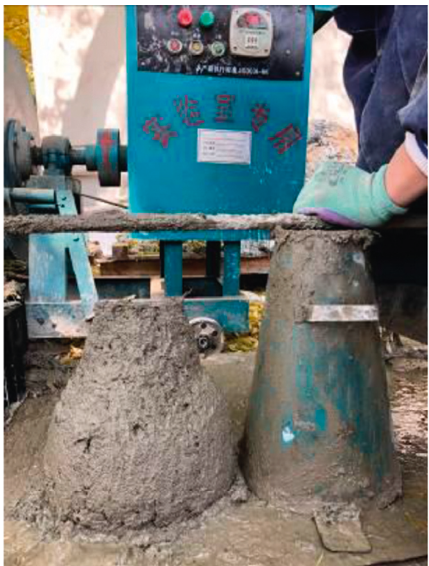
Figure 3: Concrete slump test.